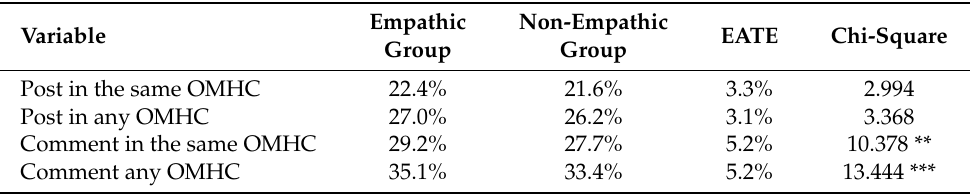
Table 2. Comparing the return probability of “empathic comment group” and “non-empathic comment group”. ** p < 0.01, *** p <